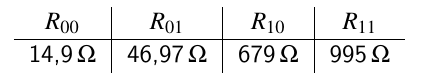
Tab.1: Calibration network consisting of four resistances used for the